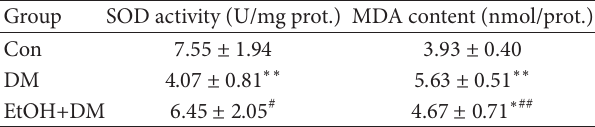
Table 2: Changes of SOD activity and MDA content in lung tissues in different groups.